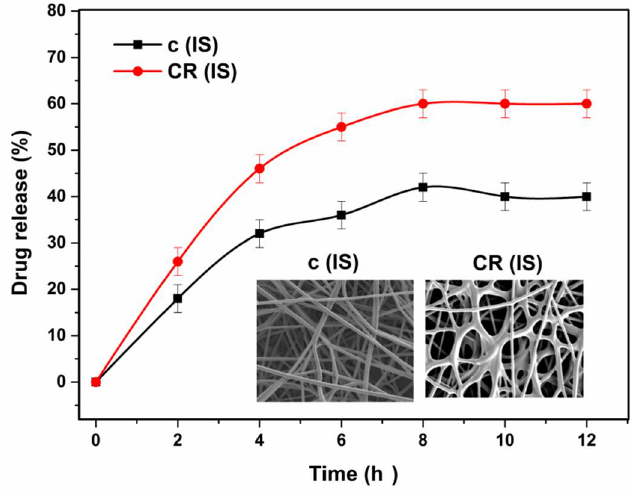
Figure 10. In vitro drug release assay of the prepared sample.